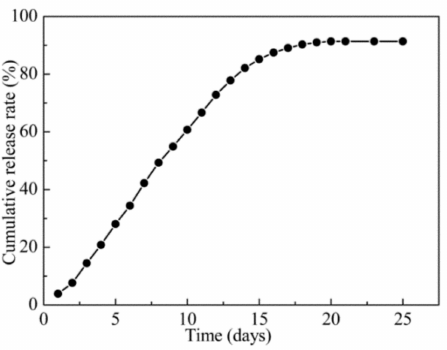
Figure 8. Cumulative release curve of the UMAO/PLGA/NG